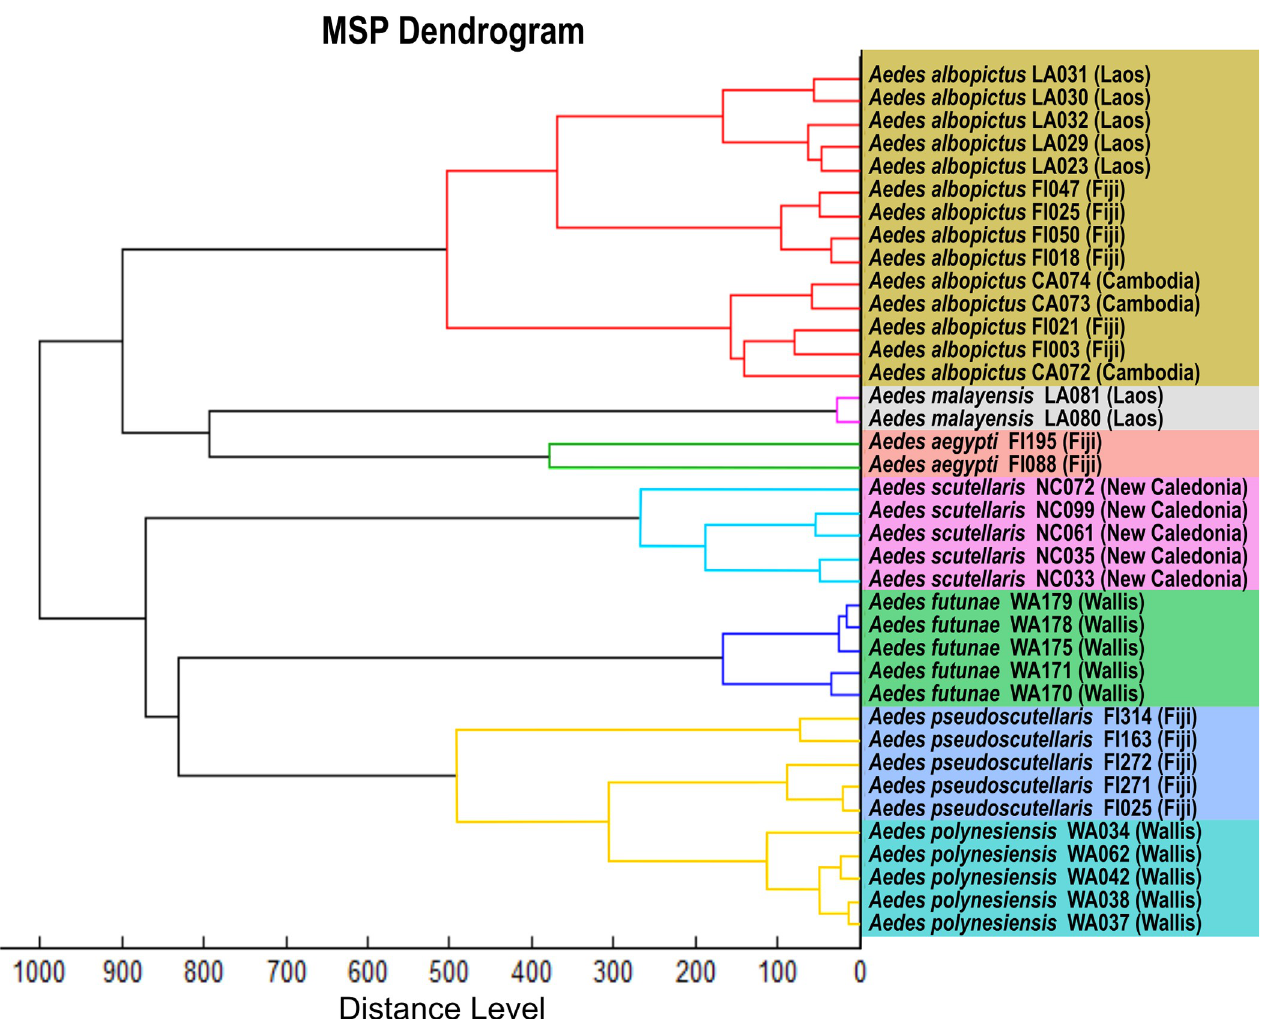
Fig 5. MSP dendrogram of all the mosquitoes belonging to the Scutellaris Group in the MALDI-TOF database. The two Aedes aegypti was used as outgroup taxa. Colors of the branches indicate mosquito species according to the cut-off of 500 (arbitrary units) previously described [41].